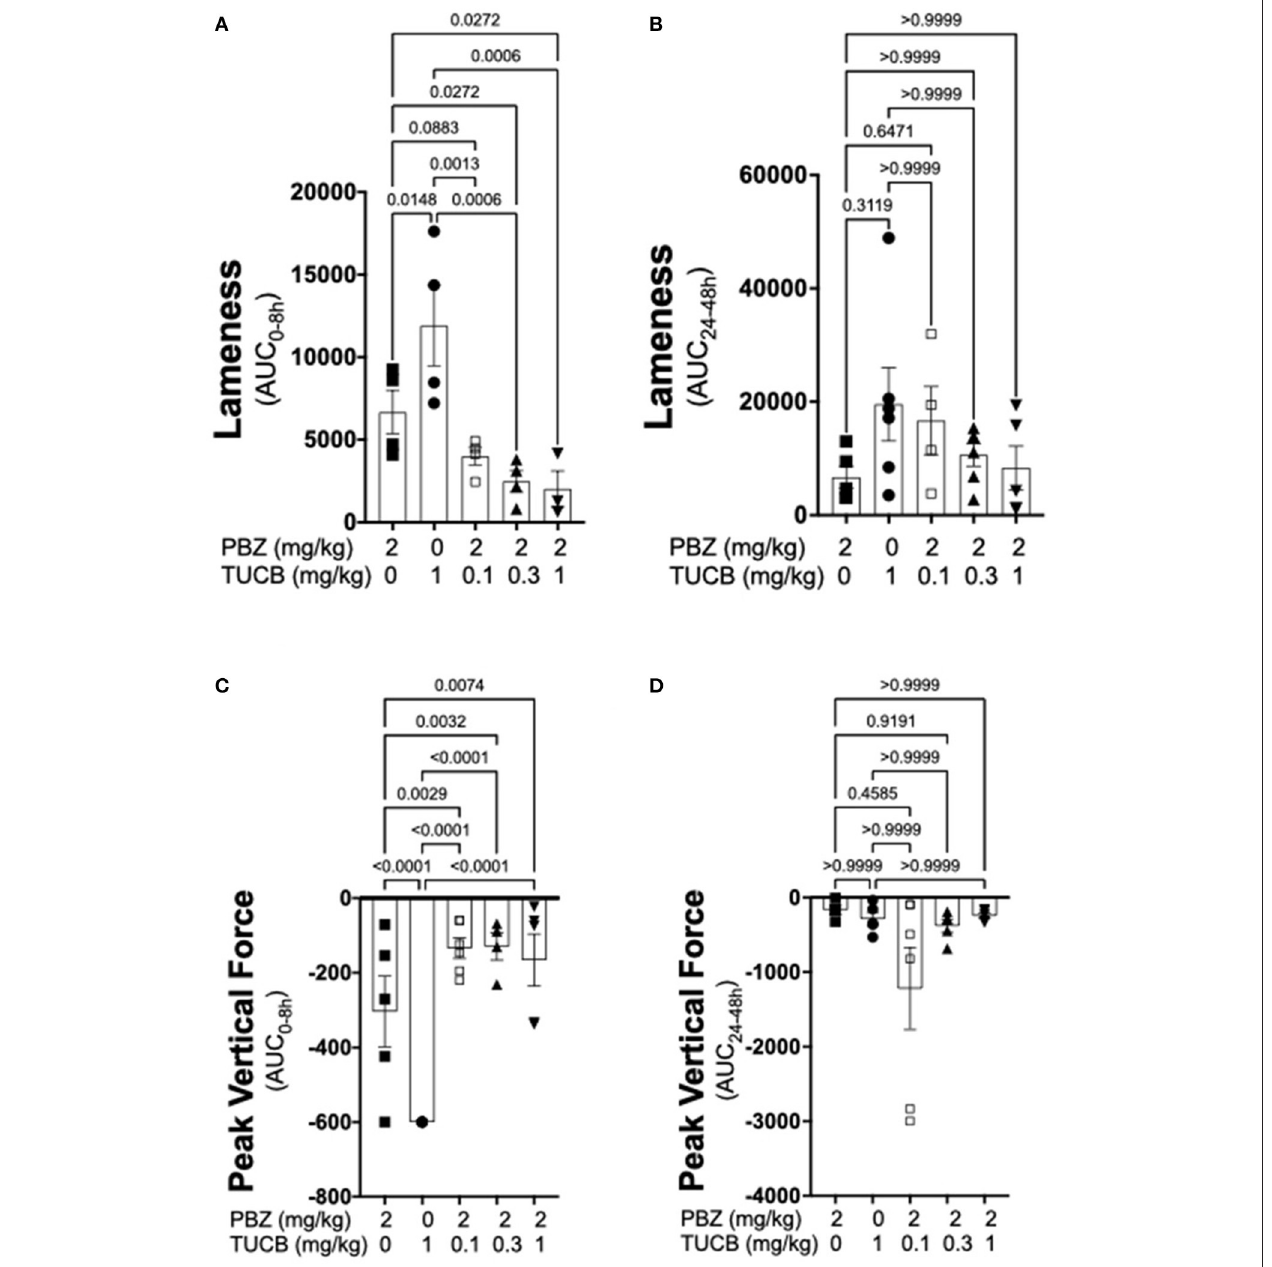
FIGURE 2 | Combined sEH and COX inhibition resulted in better control of joint pain in the early phase of synovitis than inhibiting each enzyme separately. Pain was estimated as a change in lameness that was objectively assessed via inertial sensors (A,B) as well as forces applied to an in-ground force platform (C,D) during the early, 0–8h (A,C) , and late 24–48h (B,D) phases of synovitis induced by intra-articular injection of lipopolysaccharide (LPS; 3 µ g) into the radiocarpal joint in horses ( n = 6). Horses were treated intravenously with the sEH inhibitor trans -4-{4-[3-(4-Trifluoro-methoxy-phenyl)-ureido]-cyclohexyloxy}-benzoic acid (TUCB), the non-selective COX inhibitor phenylbutazone (PBZ) or both, at the indicated doses marked below the graphs, at the same time as the intra-articular LPS injection. Data are shown as individual values (symbols) and mean ± SEM (columns) of the 8h (A,C) and 24h (B,D) aggregate area under the curve (AUC) corrected for baseline (% change). P -values are shown above each comparison (Mixed-effects model, (A,C) ; Friedman test, (B,D) ; Corrected for multiple comparisons by controlling the False Discovery Rate).